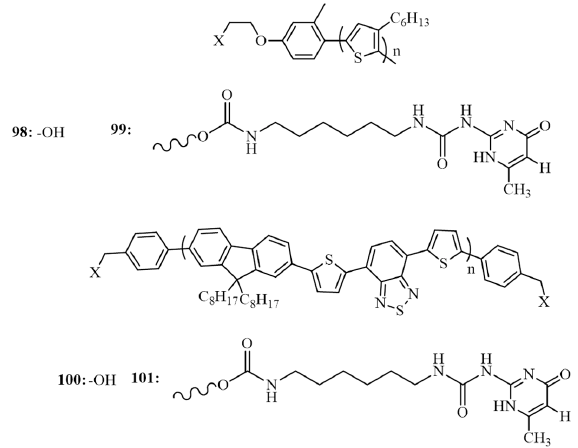
Figure 33. Chemical structures of 98 – 101 synthesized by Verduzco et al. [115].